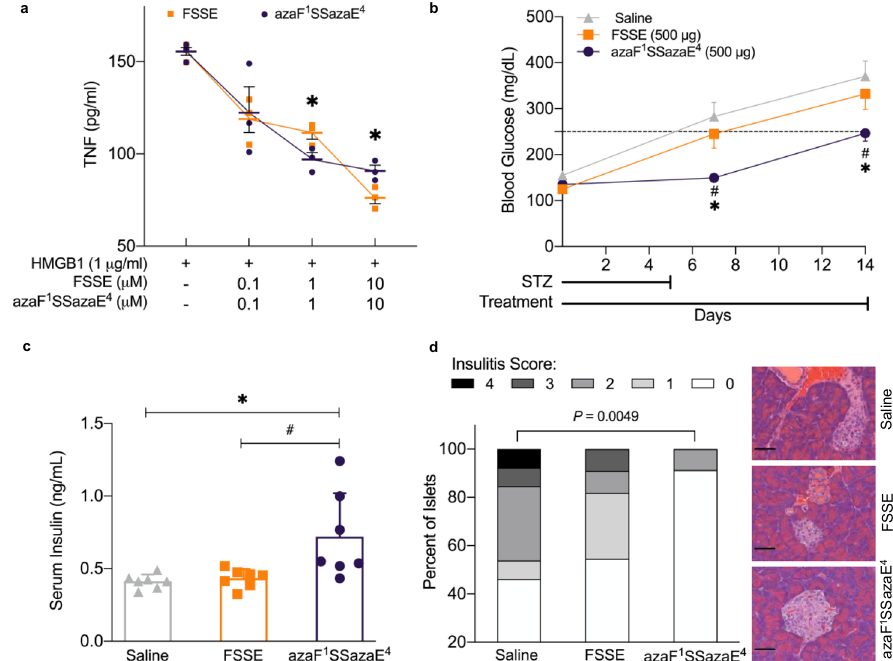
Fig. 3 | Bioactivities of end-capped azapeptide azaF 1 SSazaE 4 ( 51 ). a HMGB1/MD-2/TLR4 antagonist FSSE and azaF 1 SSazaE 4 dose-dependently reduce in vitro HMGB1- stimulatedTNFreleaseinmurinemonocytes.SplenicmonocytesfromC57BL/6Jmicewereincubatedwith0.1,1or10 µ MofFSSEorazaF 1 SSazaE 4 inthepresenceofHMGB1 (1 µ g/ml)for24h.ELISAmeasuredTNFfromcellsupernatants.Dataarepresentedasmeans±SD.Representativegraphofthreeindependentexperimentswithtriplicates. ValuesaremeasuredbyUnpaired t -testwithWelchcorrection.* p =0.046vs.FSSEgroup(at1 µ M),* p =0.033vs.FSSEgroup(at10 µ M). b-d HMGB1/MD-2/TLR4antagonist azapeptideanalogue azaF 1 SSazaE 4 delayshyperglycemiainmicechallenged withlow-dosestreptozotocin(STZ). b C57BL/6Jmalemice(6weeksof age)wereinjected i.p. with STZ (50mg/kg) in sodium citrate buffer (pH 4.5) once daily for 5days. Mice were simultaneously injected i.p. with saline, FSSE (500 µ g/mouse/day), or azaF 1 SSazaE 4 (500 µ g/mouse/day).Blood glucose was measured on day 0, 7 and 14.Number of mice per group: saline n =7; FSSE n =8; azaF 1 SSazaE 4 n =8.Data are presented asmean values±SEM.Valuesaremeasuredbytwo-wayANOVA* p =0.0004vs.salinegrouponday7,* p =0.0009vs.salinegroup onday14;# p =0.0094vs.FSSEgrouponday7, # p =0.0218 vs. FSSE group on day 14. Values above the dashed line indicate type 1 diabetes. c Serum levels of insulin are increased in animals treated with azaF 1 SSazaE 4 . Serumsamplesfrommicechallenged withSTZwerecollected atday14andanalyzedbyELISA. n =7micepergroup.Dataarepresented asmeanvalues±SEM.Valuesare measuredby1-wayANOVAwithTukey ’ smultiplecomparisontest,* p =0.0124vs.salinegroup,# p =0.0198vs.FSSEgroup. d InsulitisisreducedinmicetreatedwithFSSE andazaF 1 SSazaE 4 ascomparedtosalinetreatedmice.Percentageoftotalisletsexhibitingvariousdegreesofinsulitis(score0-4)following2weeksoftreatmentwithsaline, FSSE,orazaF 1 SSazaE 4 (leftpanel).Numberofisletspergroup:saline n =3,13islets;FSSE n =2,11islets;azaF 1 SSazaE 4 n =3,23islets. P -valuewascalculatedusingtwo-sided Fisher ’ sexacttesttocompareisletswithout(score0)andwith(score1-4)insulitis.Pancreastissuewashistologicallyanalyzedfrom2 – 3animalspergroup.Representative hematoxylin and eosin (H&E) stained images of islets from each group are shown (right panel). Scale bars, 50 μ